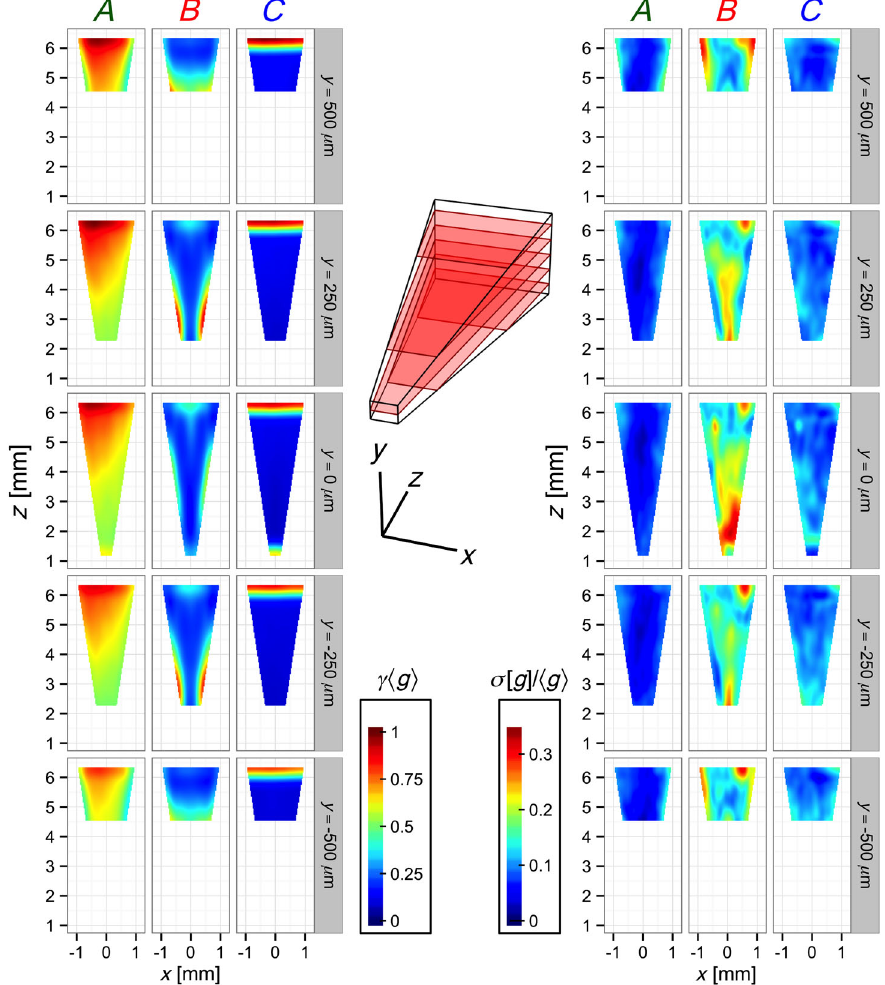
FIG. 4. Spatial distributions of microbes in the imaging volume. Using data from the ten replicates in the I ¼ I 0 illumination condition [Figs. 1(d) and 2(b)], the time-averaged spatial density g ð i Þ s ð x; y; z Þ of each species s and replicate i was calculated as described in x; y; z Þi and coefficient of variation, σ ½ g x; y; z Þ(cid:2) = h g x; y; z Þi , of the time-averaged spatial density were Appendix B 4. The mean h g s ð s ð s ð calculated over replicates. These three-dimensional statistics of spatial density were sliced along five planes of constant y , as shown by the transparent red slices in the central schematic view of the monitored volume [see Fig. 1(a)], and plotted as heat maps within each slice (left panel, normalized mean; right panel, coefficient of variation). Within each panel, species are sorted by column [left column, g x; y; z Þi is shown, where C. reinhardtii ( A ); center column, E. coli ( B ); right column, T. thermophila ( C )]. The normalized mean γ s h s ð γ − 1 g x; y; z Þi max x;y;z h s ð s ¼